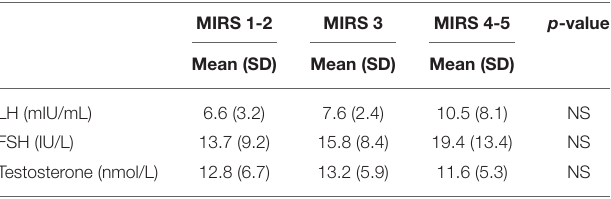
TABLE 4 | LH, FSH, and testosterone levels in male patients divided by severity of muscular